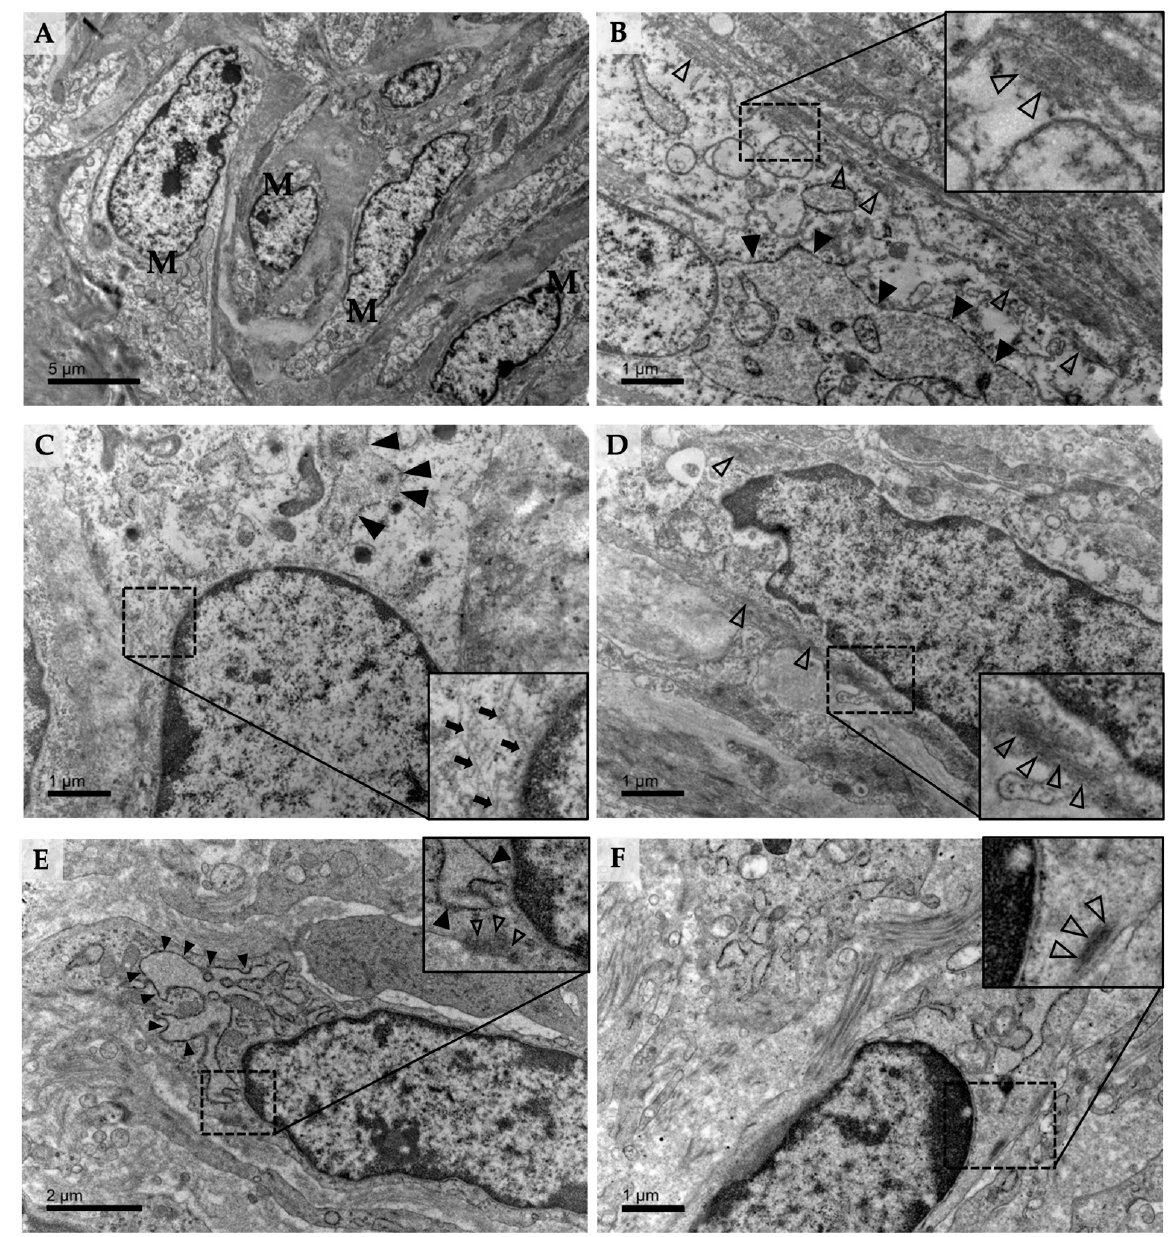
Figure 2. Transmission electron micrographs of bovine placentomes around parturition ( A – D ) or non-pregnant caruncle samples ( E , F ). ( A ) Ultrastructural overview of neighboring myofibroblasts (M). ( B ) Close up of a single myofibroblast, showing characteristic expanded cisternae of ER (filled arrowheads) and stress fibers (empty arrowheads) associated with either dense bodies or focal adhesions (inset). ( C ) Extended ER cisternae (full arrowheads) and perinuclear intermediate filaments (small arrows) are frequently observed. ( D ) A myofibroblast shows several strands and bundles of stress fibers (empty arrowheads), especially close to the cell membrane (inset). ( E ) Myofibroblast in the caruncular stroma. Representative enlarged ER cisternae (full arrowheads) and compacted stress fibers (empty arrowheads), attached to focal adhesions, can be detected (inset). ( F ) A single myofibroblast is demonstrated with characteristic stress fibers, attached to focal adhesions (dotted rectangle). A higher magnification is presented in the inset and shows the stress fibers attached to a focal adhesion at the cell membrane (empty arrowheads).